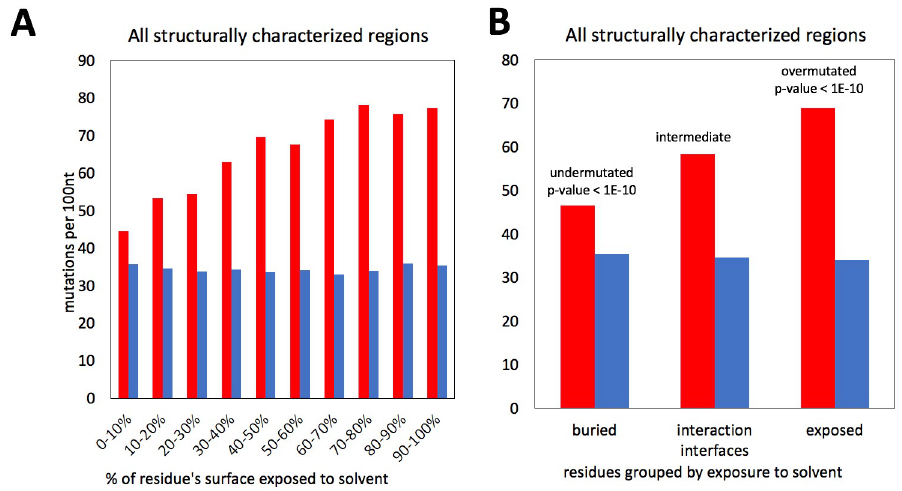
Fig 3. Frequencies of missense (red) and synonymous (blue) mutations for residues buried in the protein core, exposed to the solvent and involved in known protein-protein interfaces. A) The purifying selection decreases with increasing solvent exposure. B) Exposed residues are very over-mutated and buried residues are very under-mutated. For interfaces, the mutation rate falls between that for exposed and buried